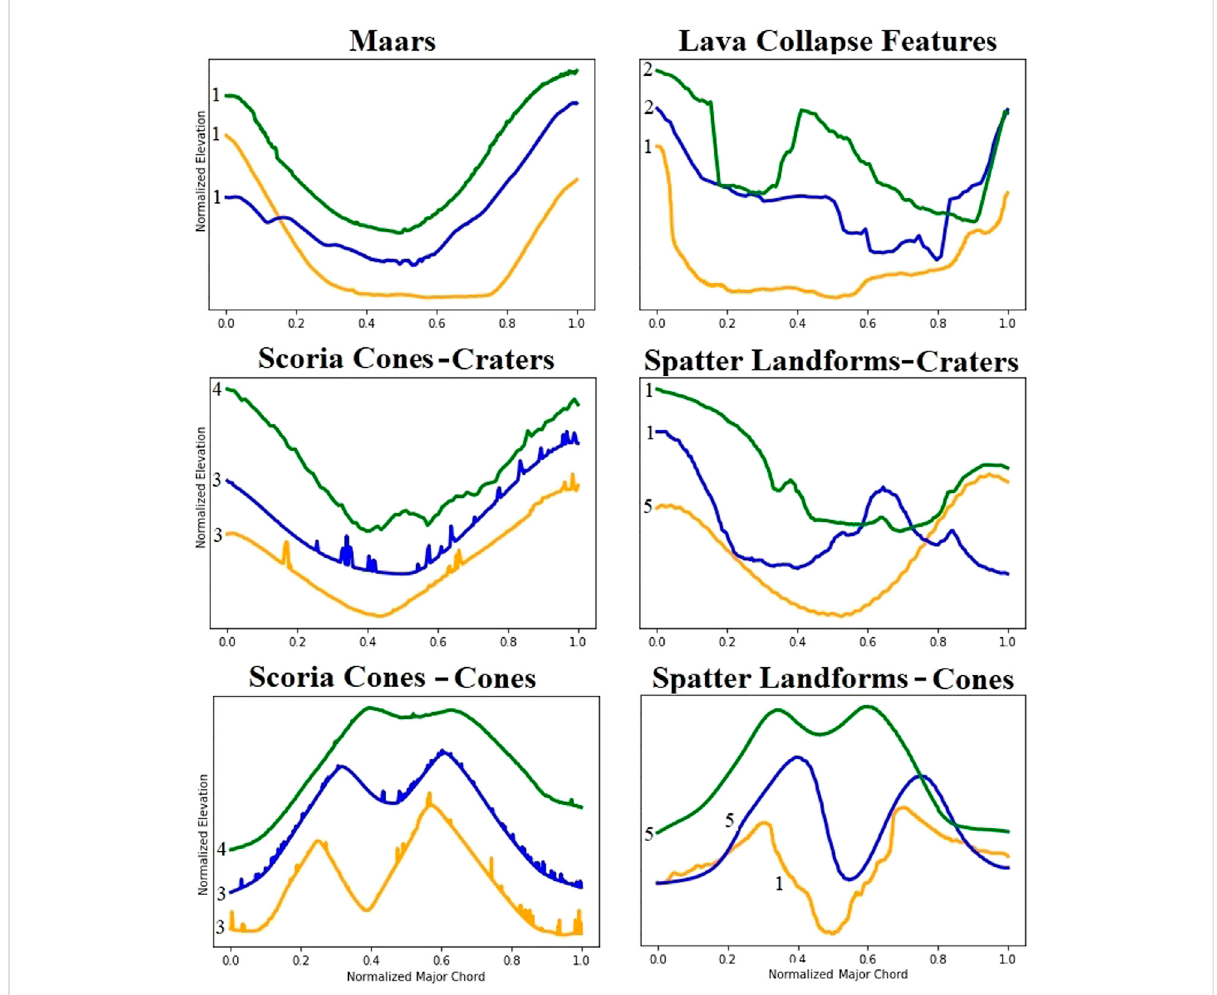
FIGURE 3 ExamplesofSMILESmajorchordtopographicpro fi les.The x and y axeshavebeennormalizedtoremovescalingissuestohighlightthediversity of landform pro fi les. 1). Diamond Craters, Oregon, United States. 2). Pu ’ u O ’ o, Hawaii, United States. 3). EL Malpais, New Mexico, United States. 4). Bryce Canyon, Utah, United States. 5). Laki,